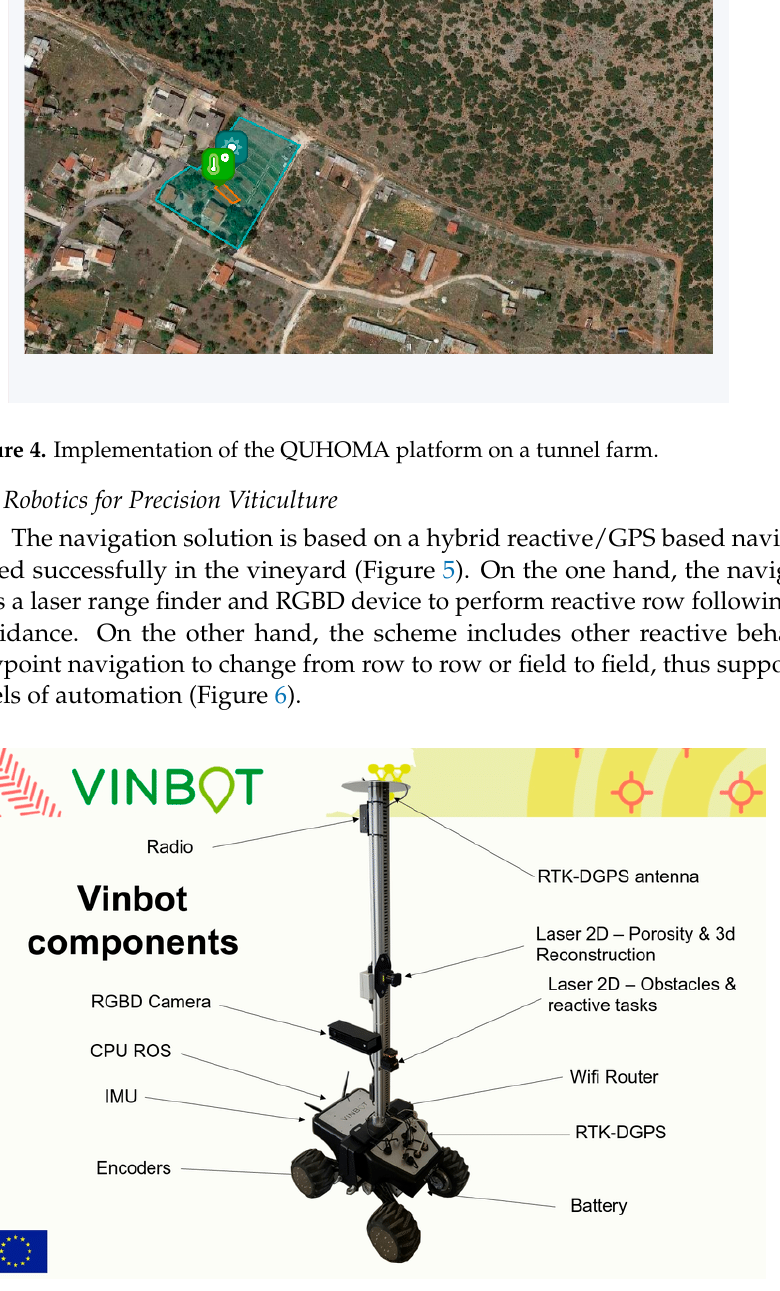
Figure 6. Block diagram of feature extractor service architecture. A ground truth evaluation trial was set up in an experimental vineyard in Lisbon with two plots of the white varieties “Alvarinho” and “Arinto”. For each varietal plot, six smart points were selected with 10 contiguous vines each [23]. During the ripening period of the 2016 season, the vines were manually assessed for canopy dimensions. The VINBOT platform showed an acceptable performance for the automated estimation of canopy fea- tures, although results were very dependent on the variety of the grapes (Figure 7). More- over, a general underestimation of actual yield based on the combination of image analy- sis and automatic canopy porosity assessment using a laser range finder has been ob- served. This result can be attributed to a combined effect of bunch occlusions, low accu- racy of grape detection algorithms, and empirical relationships used in final yield calcu- lations. Thus, further research on computer vision algorithms, especially related to hidden bunches by vegetation, is needed to improve the reliability and accuracy of the yield esti- mations.